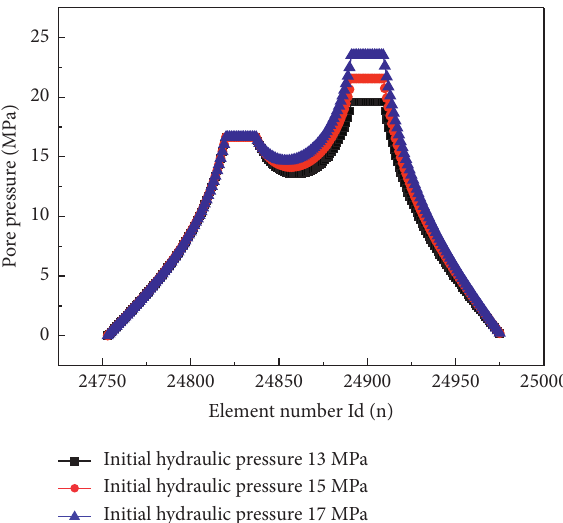
Figure 14: Pore pressure distribution along the wellbore